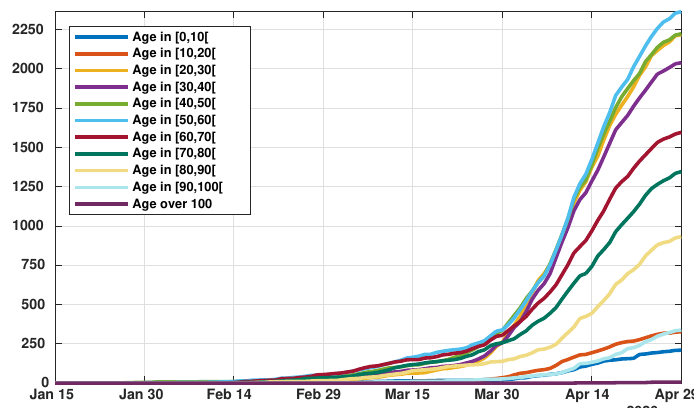
Figure 4. Time evolution of the cumulative number of reported cases of SARS-CoV-2 per age class. The vertical axis represents the total number of cumulative reported cases in each age class.